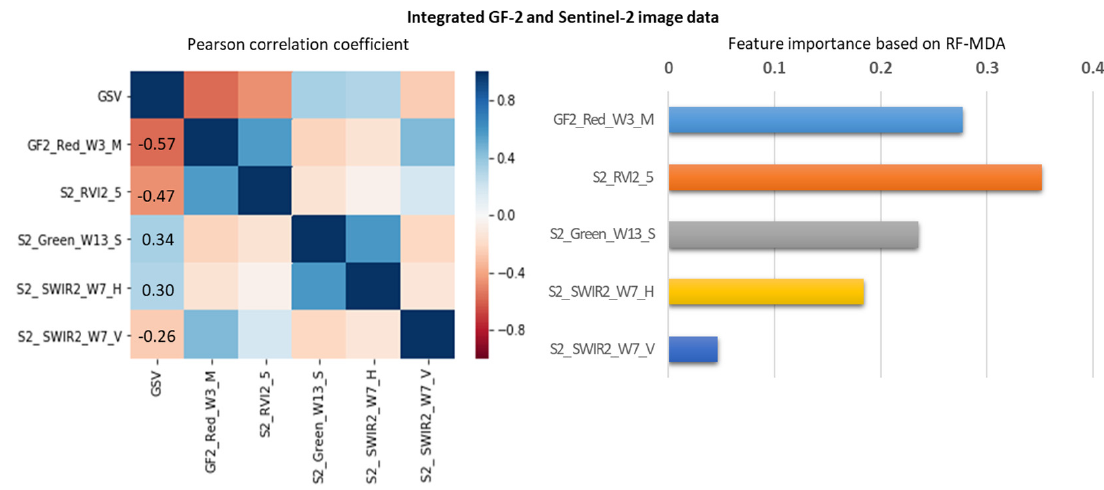
Figure 4. The correlation and importance analysis of the feature variables selected by AFCO-RFR method based on the integrated GF-2 and Sentinel-2 datasets.